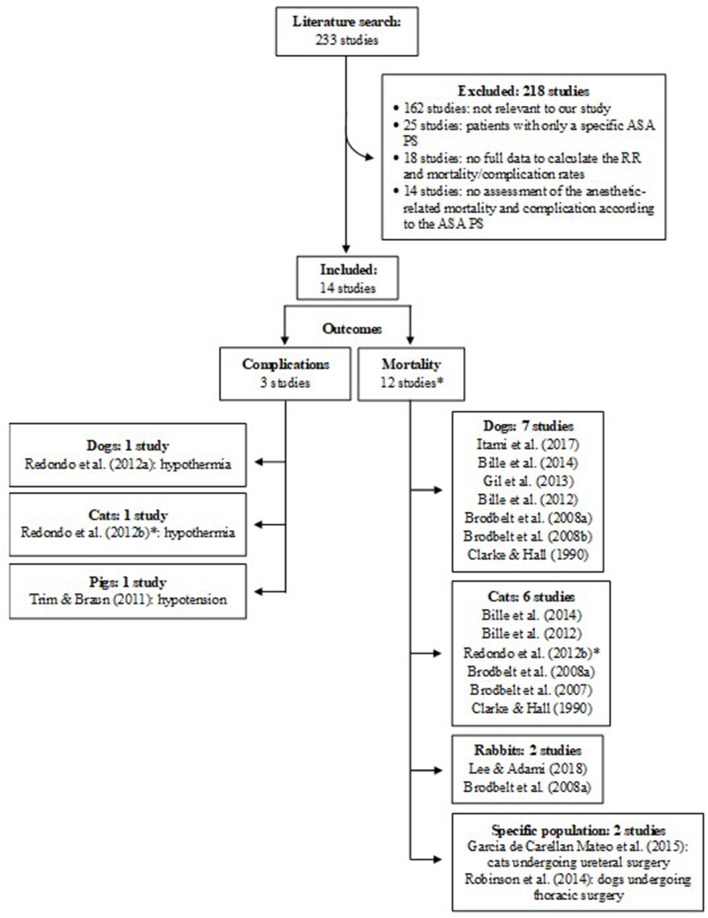
Flow diagram of studies included in the analysis. *The study of Redondo et al. (28) was counted twice because it assessed both complication and mortality. RR, relative risk; ASA PS, American Society of Anesthesiologists physical status.